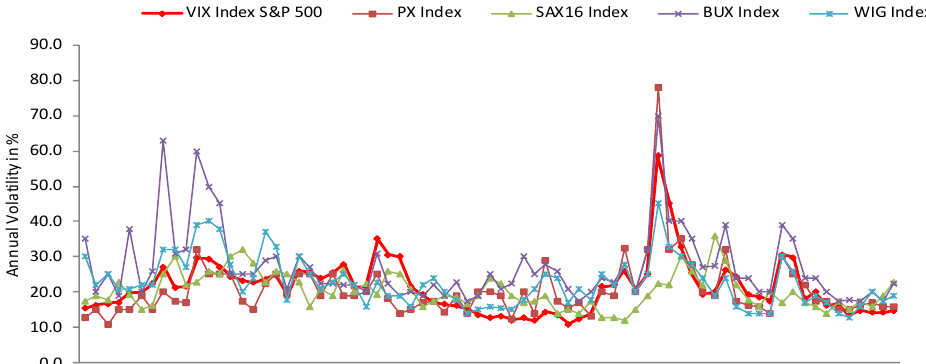
Figure 1. Development of the VIX index and the indicators of the perception of uncertainties among companies in the V4